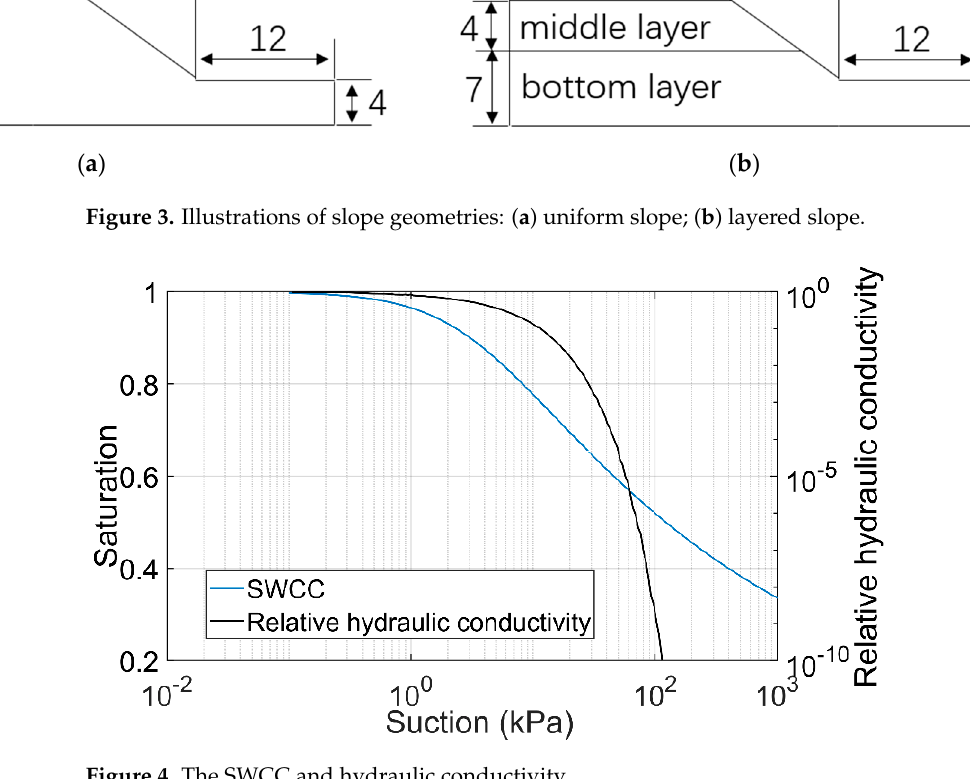
Figure 4. The SWCC and hydraulic conductivity. Table 1. Parameters used in the simulation of rainfall-induced landslides.